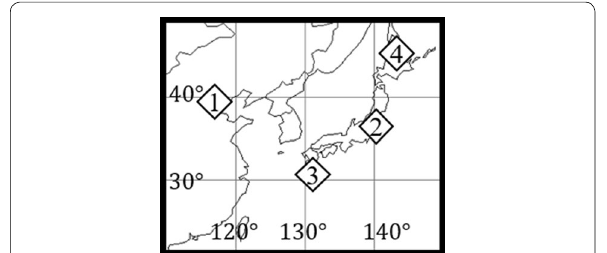
Fig. 2 Location of each (geo)magnetic observatory. (1) Beijing Ming Tombs (BMT). (2) Kakioka (KAK). (3) Kanoya (KNY). (4) Memambetsu (MMB). The original of this map without any annotation can be downloaded from Craft MAP (http://www.craft map.box‑i.net/world .php; Accessed 26 Dec 2019)